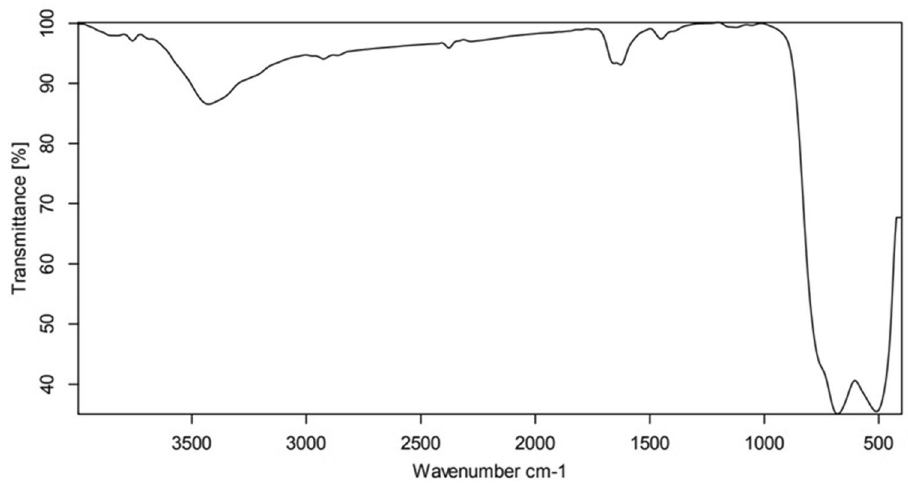
Figure 3. FTIR of TiO 2 Nanoparticles.